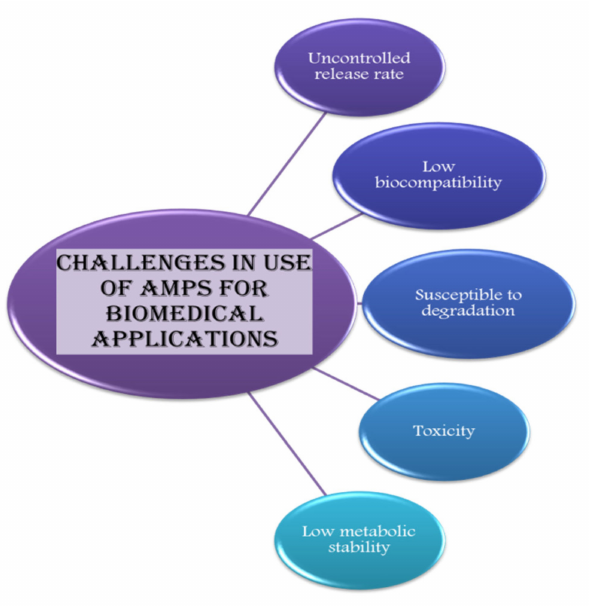
Figure 4. Amps can be used for various applications in the biomedical sector but its use is limited due to certain challenges, which are mentioned in this diagrammatic